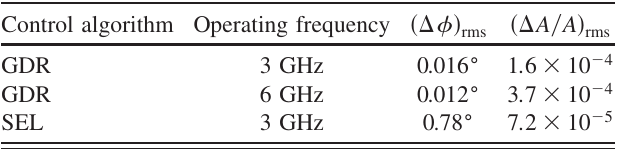
TABLE I. Residual phase and amplitude errors accomplished with both phase and amplitude feedback loops